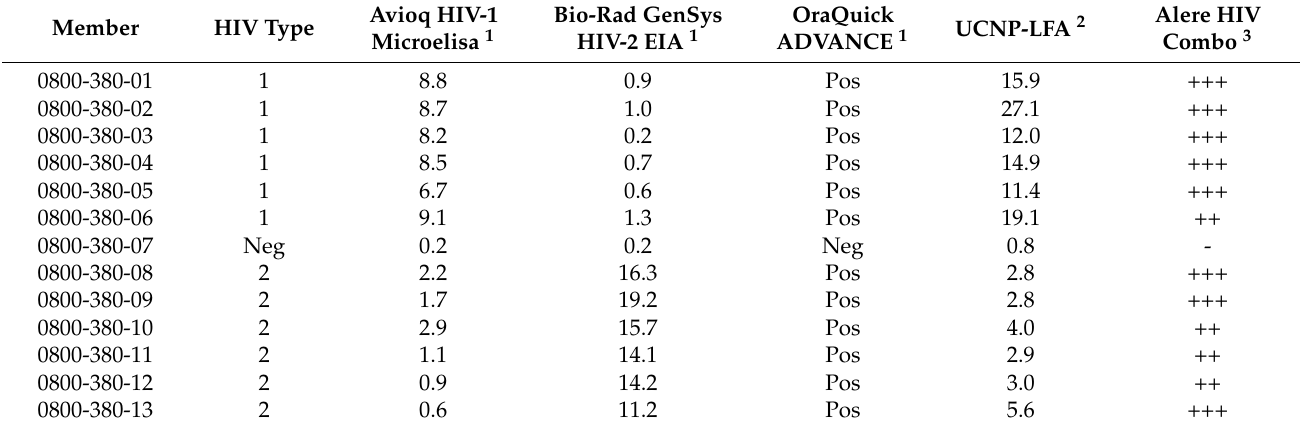
Table 8. AccuSet HIV-1/2 Performance Panel